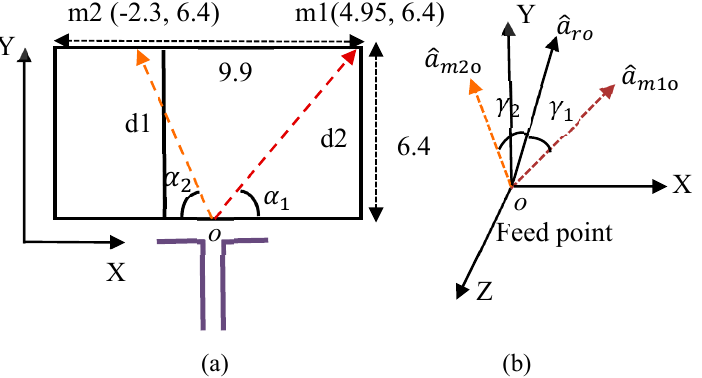
Figure 8. The EM ray routes and their locations from the feed point for array factor and radiation pattern calculations ( a ) on the structure and ( b ) on the coordinate plane.